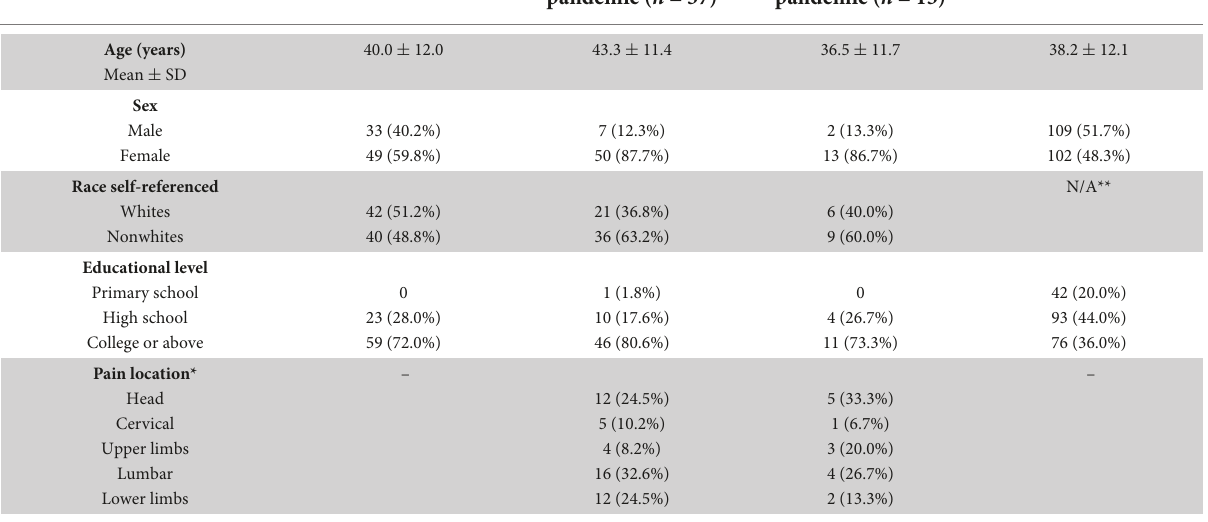
TABLE 1 Demographic variables.